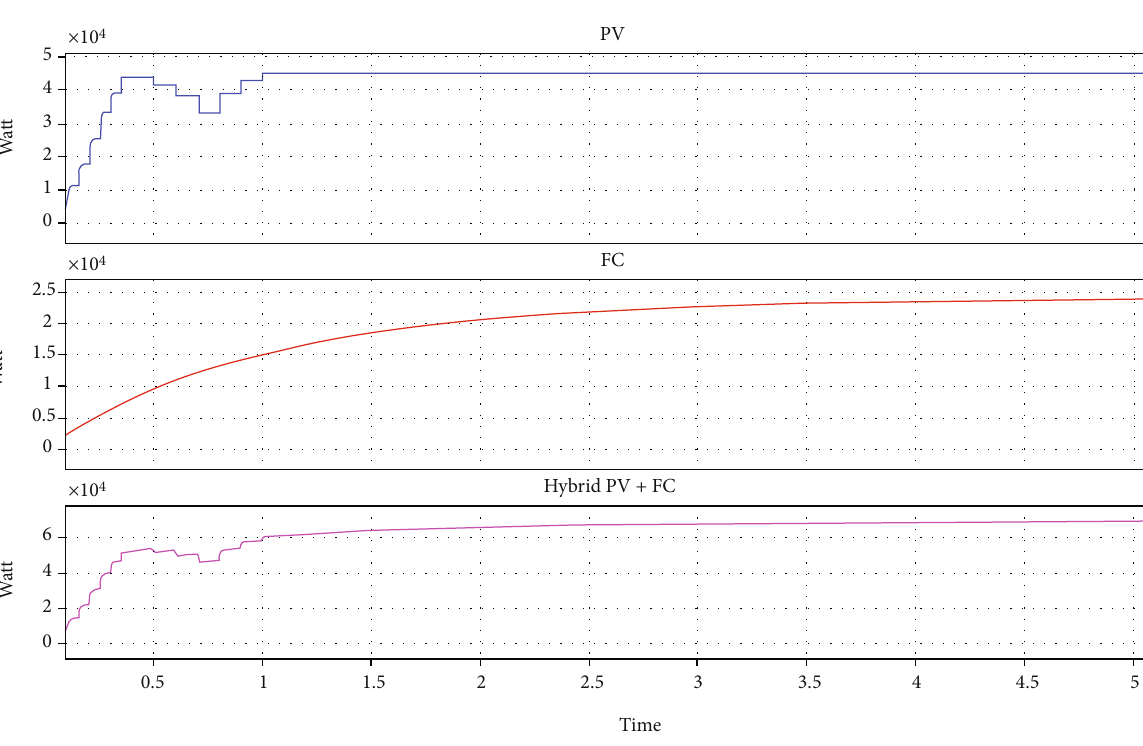
Figure 31: Total power generated by hybrid PV and FC energy